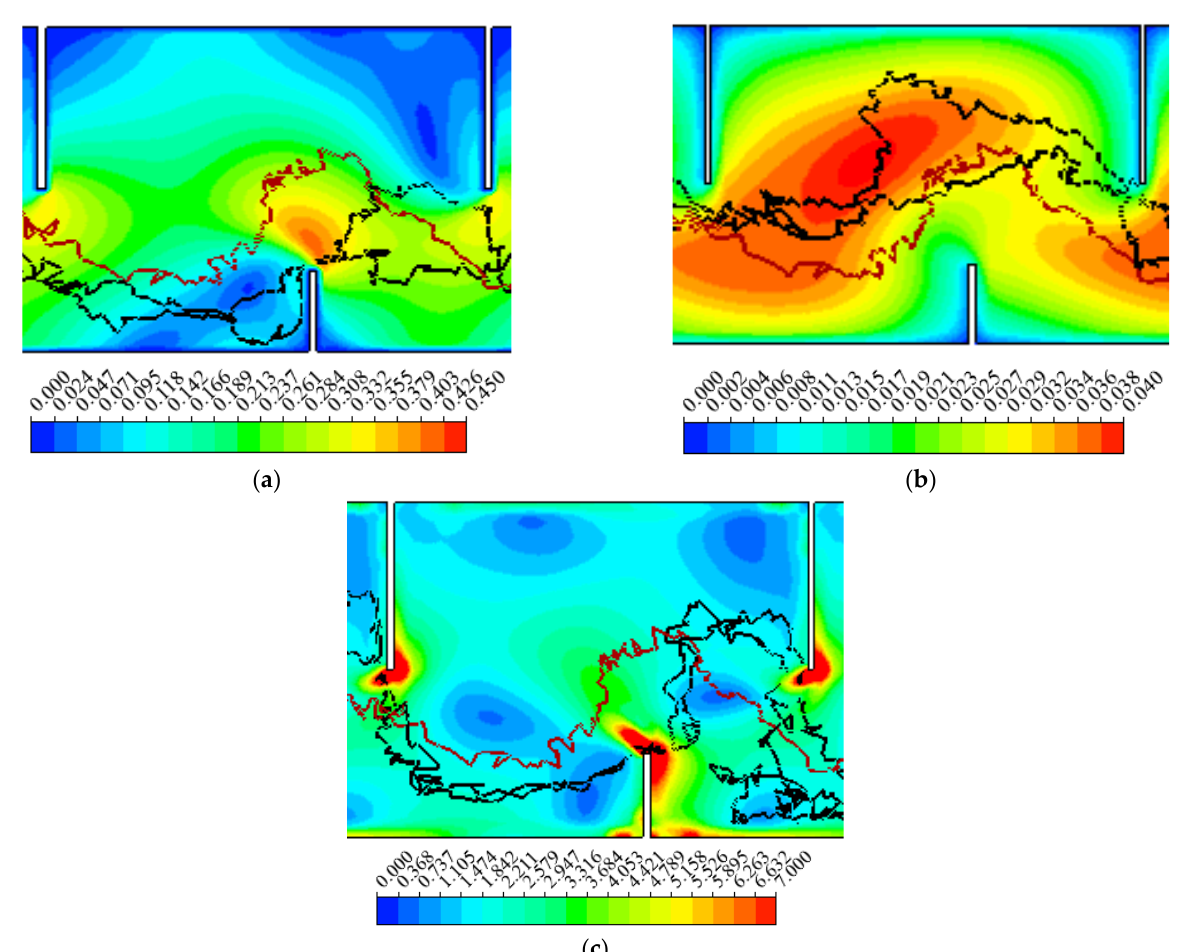
Figure 5. The movement trajectories of fish passing through typical hydraulics conditions: ( a ) typical 1: high velocity zone, velocity (m/s), ( b ) typical 2: high turbulence kinetic energy (TKE) zone, (m 2 /s 2 ), ( c ) typical 3: high SR zone (Note: the black lines represent the fish trajectories passing through high V, TKE and SR zones, and the red line represents the fish trajectories without passing through the above-mentioned high zones).